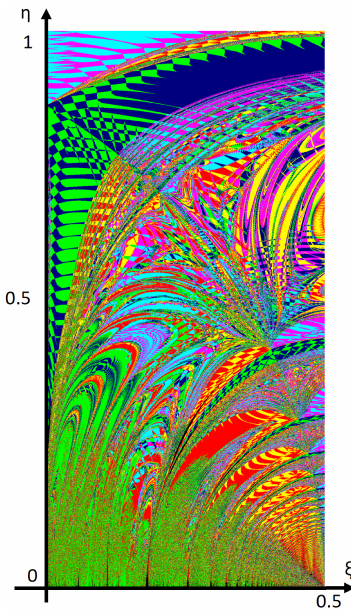
Fig. 4. 25 th symbol in the sequences for Method D.